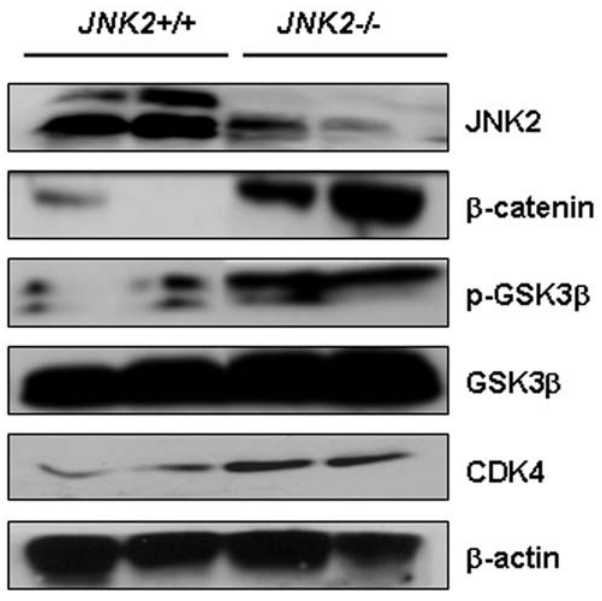
Figure 4. JNK2 deficiency caused upregulation of b -catenin and its downstream target CDK4, as well as upregulation of GSK3 b phosphorylation in JNK2-/- mouse intestinal epithelial cells, compared to those in JNK2 + / + mice. Each lane represents one mouse. b -actin served as loading control.